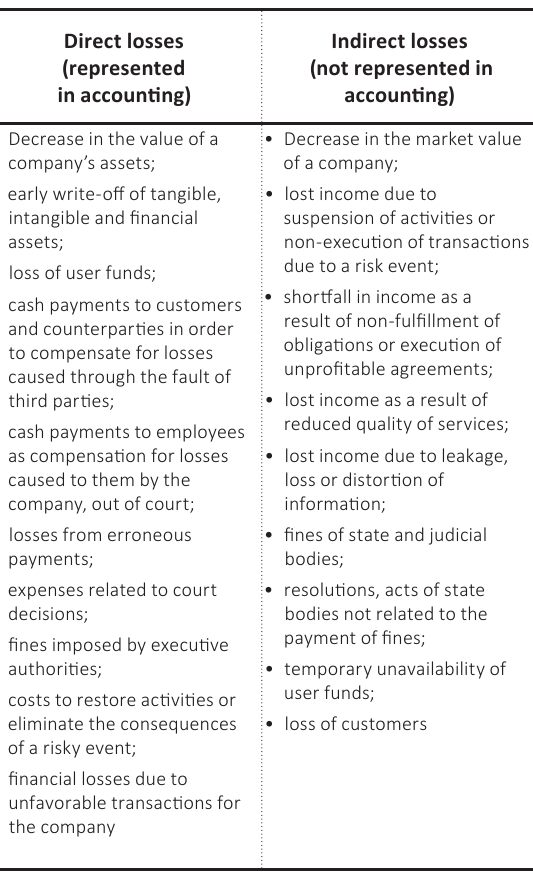
Table 6. Classification of losses (damage) as a result of operational risk